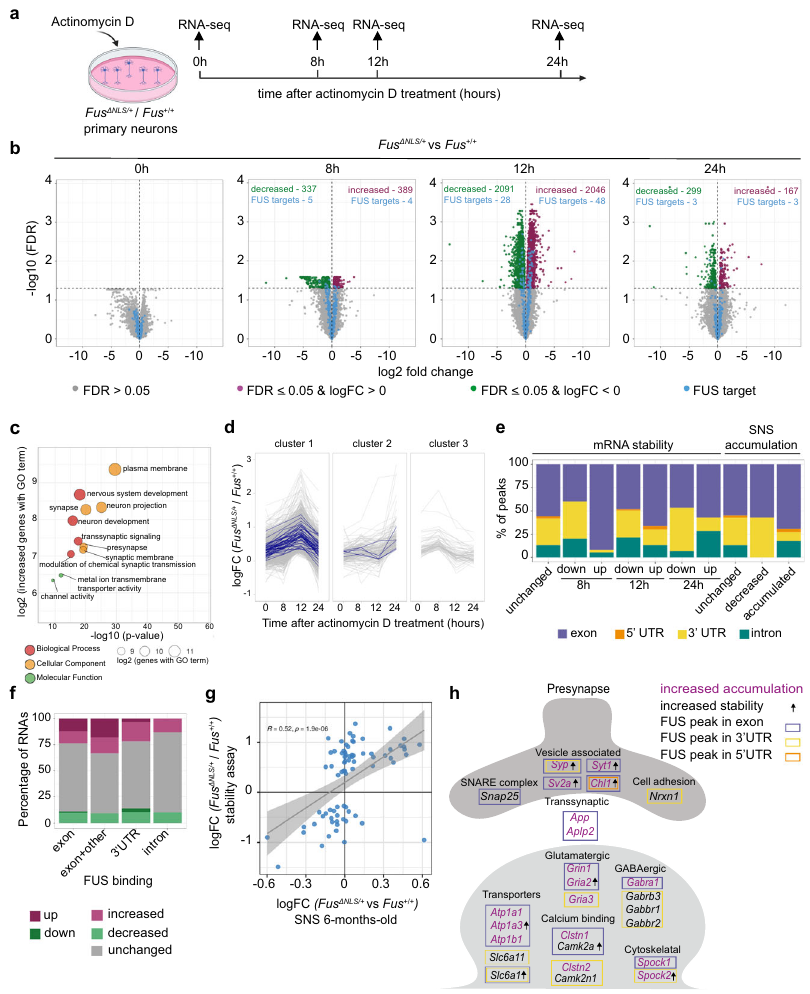
Fig. 5 Cytoplasmic FUS accumulation in Fus Δ NLS/ + neurons leads to increased stability of synaptic mRNAs. a Work fl ow of the RNA stability experiment. b Volcano plots showing the log2 fold change of each mRNA and the corresponding − log10 (FDR) of the differential gene expression analysis comparing Fus Δ NLS/ + to Fus + / + samples at each time point with signi fi cance threshold 0.05 (horizontal line). Signi fi cantly decreased mRNAs are highlighted in green, increased in purple and all synaptic FUS targets identi fi ed in the CLIP-seq data in blue. c Selected GO terms enriched in the set of signi fi cantly increased mRNAs at 12 h. One-sided hypergeometric test, p -value unadjusted for multiple comparisons. d Hierarchical clustering of the log fold changes of the set of increased mRNAs to three groups. The x -axis shows the time points and the y-axis the logFC ( Fus Δ NLS/ + / Fus + / + ); synaptic FUS targets are highlighted in blue. e Bar plot of different sets of synaptic FUS targets and the location of synapse-speci fi c peaks in these genes. FUS targets with no stability change in Fus Δ NLS/ + compared to Fus + / + (unchanged) and the sets of signi fi cantly changed mRNAs (up or down) at 8, 12, and 24 h after treatment. The three rightmost bars comprise the FUS targets with no change in synaptoneurosomes (SNS) at 6-months (unchanged), accumulated and decreased targets. f Bar plot of FUS targets grouped by binding location and the percentage of targets with a speci fi c RNA level change. Targets with the majority of peaks in exons (exon), equal number of peaks in exons and UTR/intron (exon + other), majority of peaks in 3 ′ UTR (3 ′ UTR) and majority of peaks in introns (intron). Accumulated RNAs in 6-month-old SNS (up), RNAs with increases stability (increased), unchanged RNA levels (unchanged), less abundant RNAs in 6- month-old SNS (down) and less stable RNAs (decreased). g Log2 fold change ( Fus Δ NLS/ + / Fus + / + ) of the stability experiment at 12 h ( y -axis) and SNS of 6- month-old mice ( x -axis) for all synaptic FUS targets with signi fi cant changes in stability at 12 h (blue points, n = 76 mRNAs). R = Pearson correlation coef fi cient, p = p-value (two-sided Pearson correlation test), linear fi t (gray line) and 95% con fi dence interval (gray region). h Summary of the observed changes for selected synaptic FUS targets. RNAs that were accumulated in synaptoneurosomes of 6-month-old Fus Δ NLS/ + mice are highlighted in magenta; RNAs with increased stability at any time point are indicated by a small arrow; the colored boxes indicate the location of the synaptoneurosome-speci fi c FUS